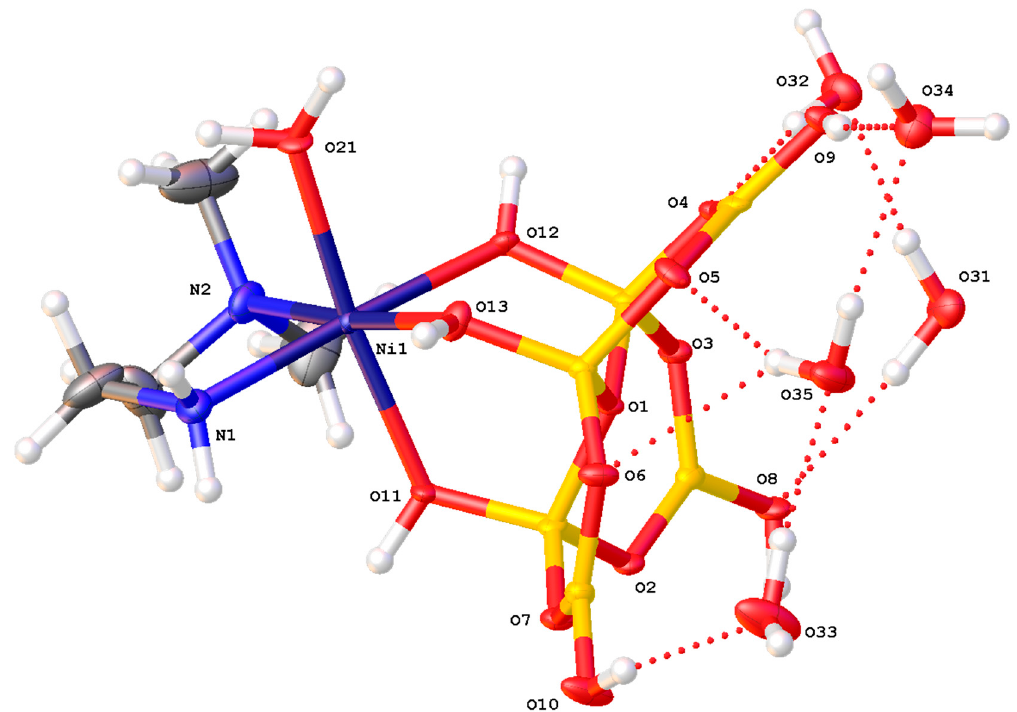
Figure 4. Drawing of structure of [Ni(dmen)(H 2 O){B 6 O 7 (OH) 6 }] . 5H 2 O ( 8 ), showing (selected) crystallographic numbering.